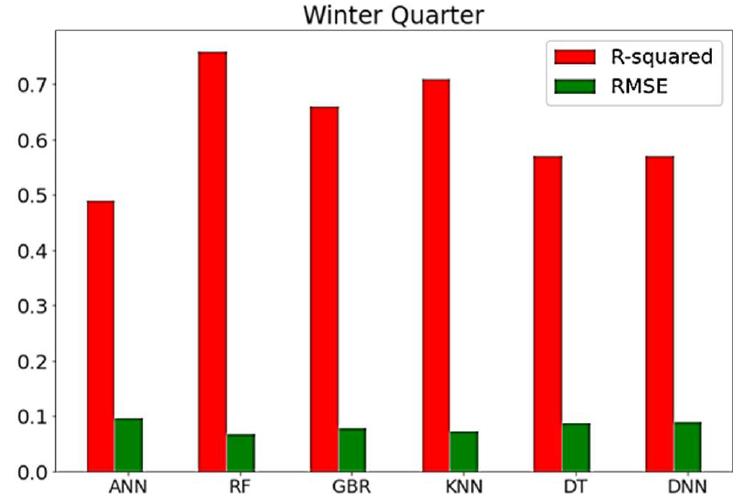
Figure 9. R 2 and RMSE metrics for the ML algorithms winter data set.